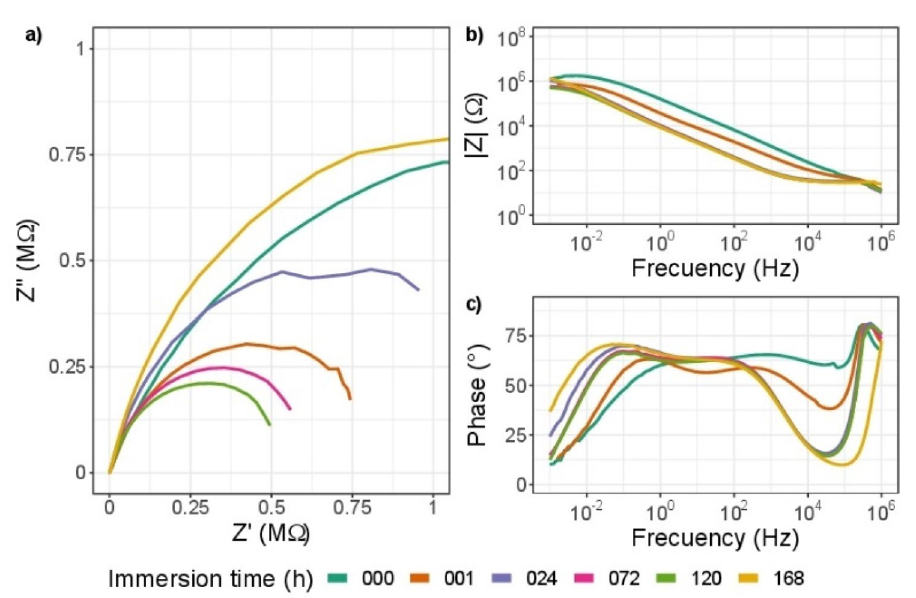
Figure 15. EIS diagram for impedance modulus obtained after different immersion times in 3.5% wt NaCl solution for